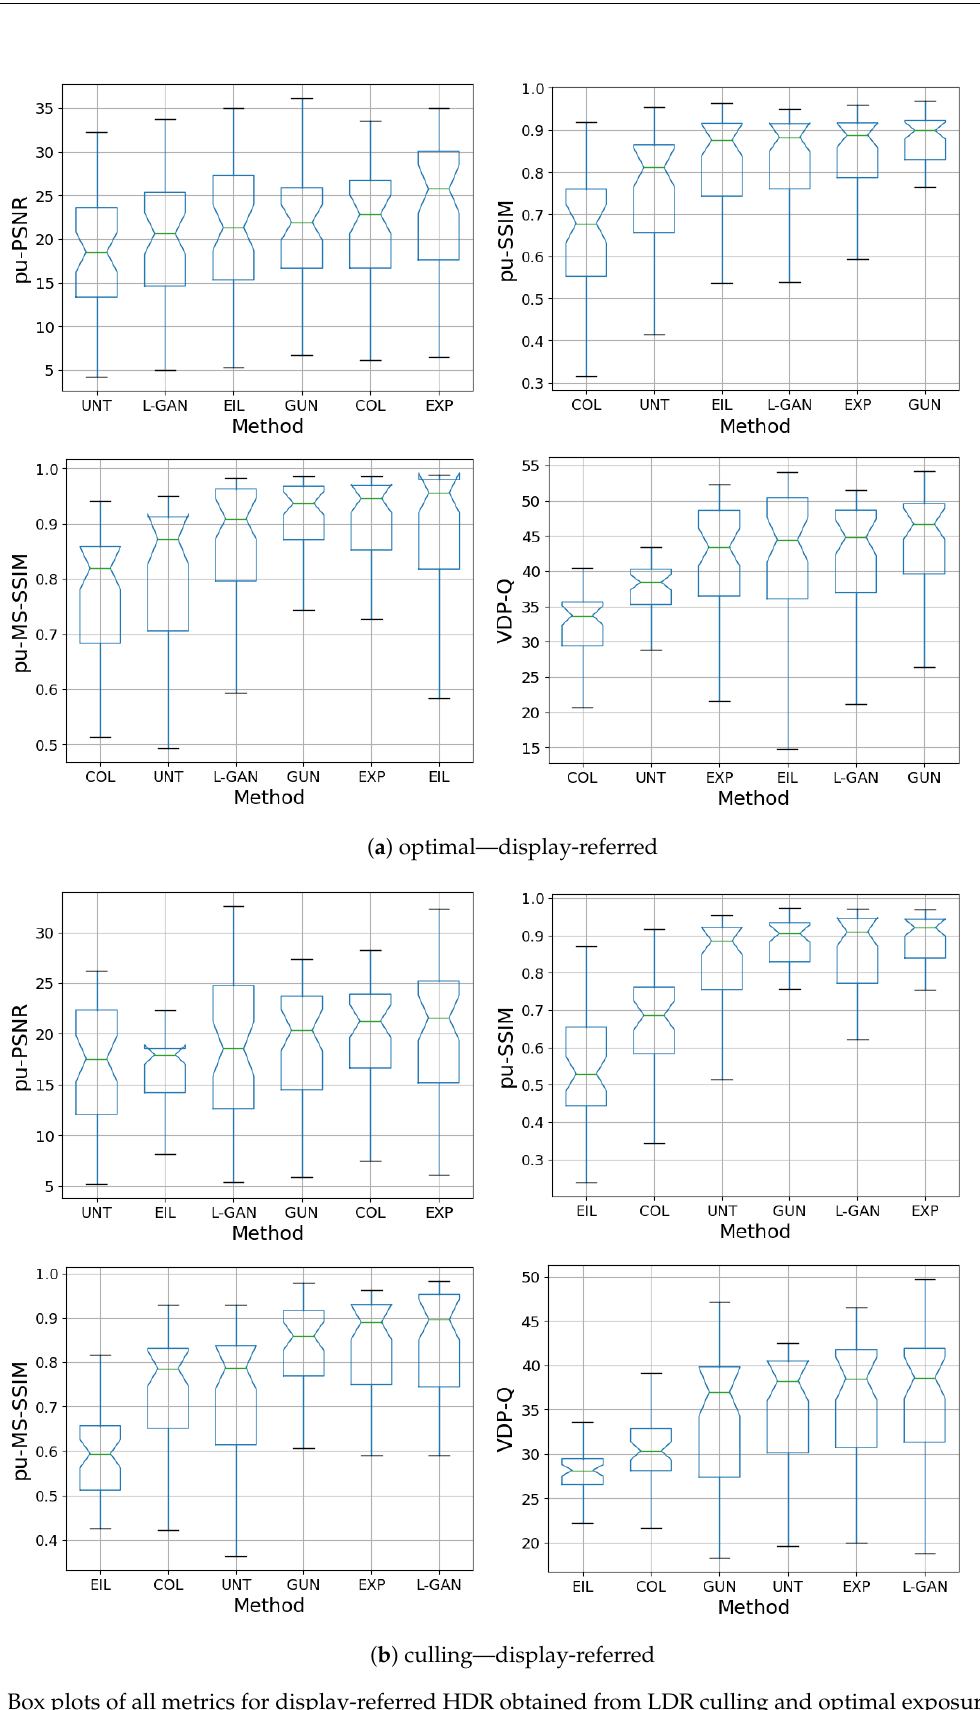
Figure 8. Box plots of all metrics for display-referred HDR obtained from LDR culling and optimal exposures. The DHH method is referred to as L-GAN in the